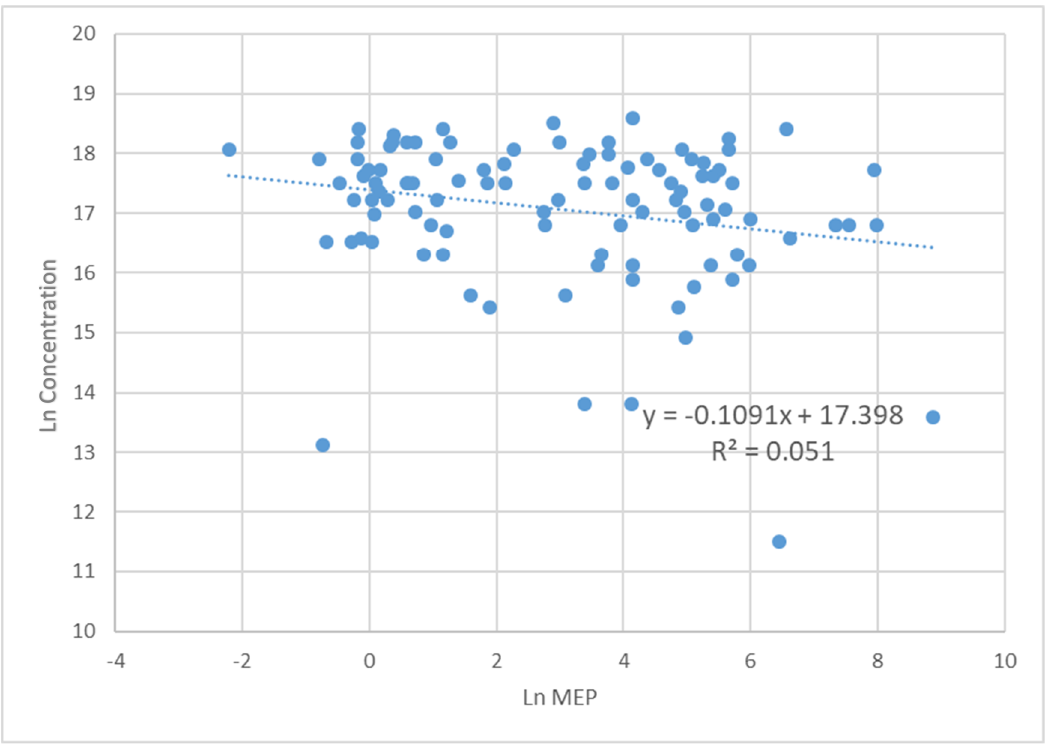
Figure 2. Scatterplot of semen concentration, as natural logarithm, vs Ln(MEP), with superimposed regression line from the covariate adjusted model.